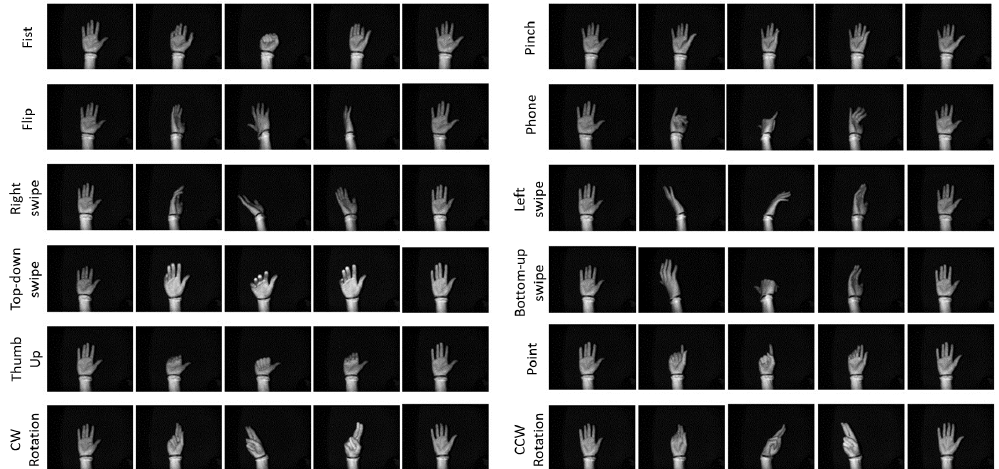
Figure 3. Dynamic gesture classes contained in the Briareo dataset. All gestures are designed for the interaction between an user, i.e., the driver, and a traditional infotainment system, in which it is possible for instance skipping song (“right/left swipes”) or make a phone call (“phone”). Here, frames are taken from the infrared domain. Image taken from